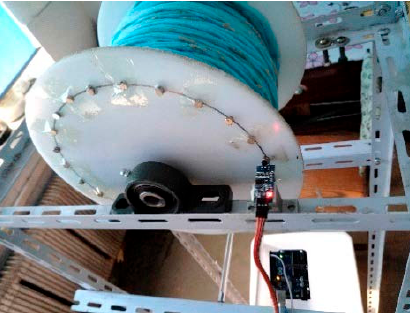
Figure 6. The tape guiding system [83].